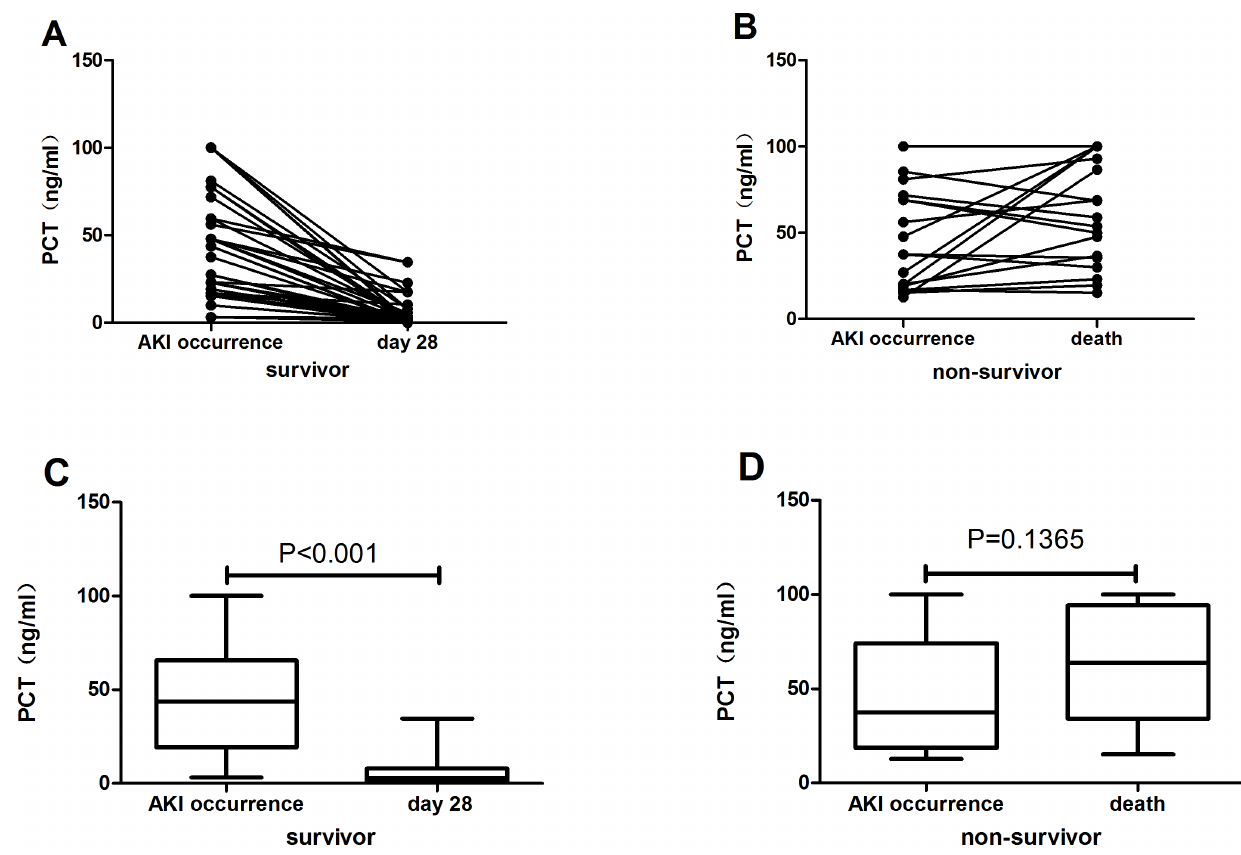
Figure 7. Relationship between serum PCT levels and prognosis. A. The trend of serum PCT levels in survivors during the period from AKI occurrence to termination of follow up. B. The trend of PCT levels in non-survivors during the period from AKI occurrence to death. C. Serum PCT levels on the days of AKI occurrence and of termination of follow-up in survivors. D. Serum PCT levels on the days of AKI occurrence and of death in non-survivors. PCT levels of the two days were each compared using the Wilcoxon signed-rank